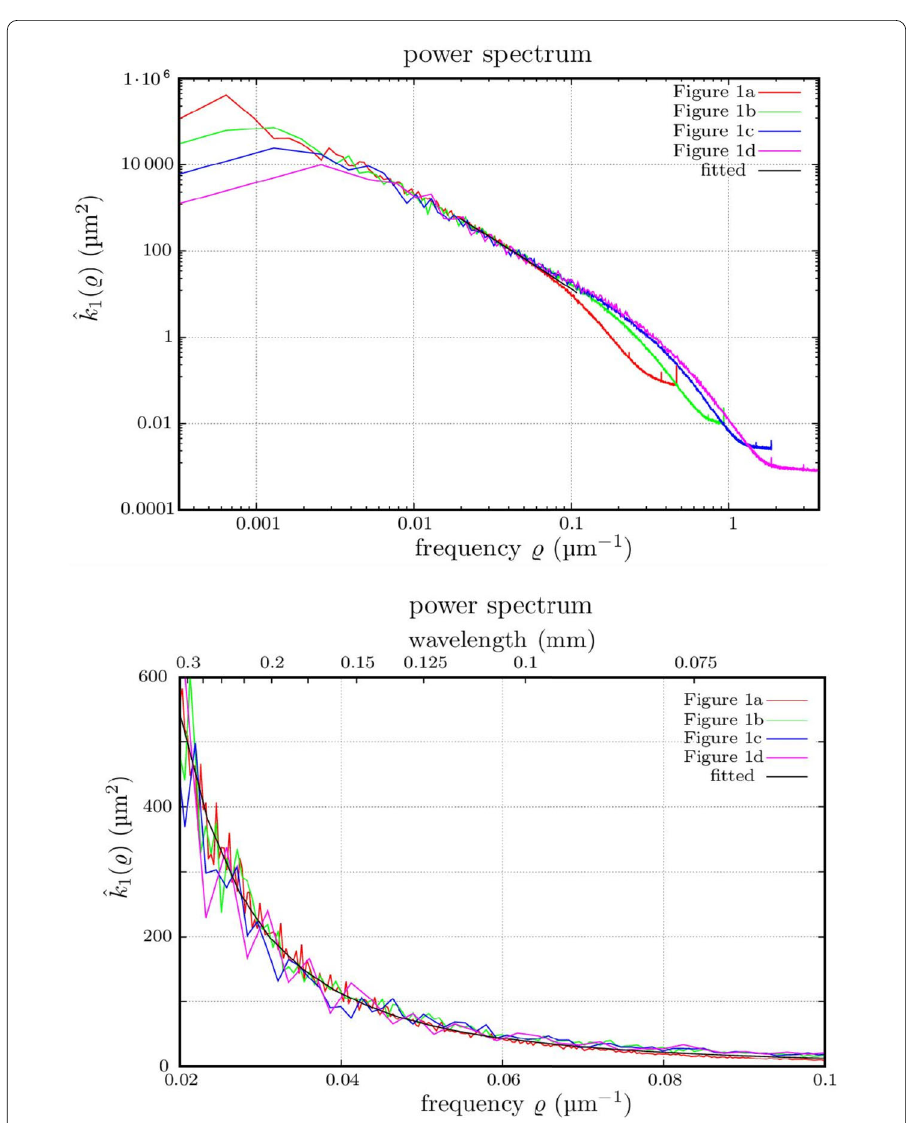
Figure 9 Estimates of the power spectrum of the nonwoven FL1 from the images in Figs. 7a-d and the function from (7) fitted to the power spectrum of Fig. 7a with λ = 6.4 mm –1 and ν = 0.231. Top: logarithmic scale. Bottom: zoomed into sub-range, linear scale